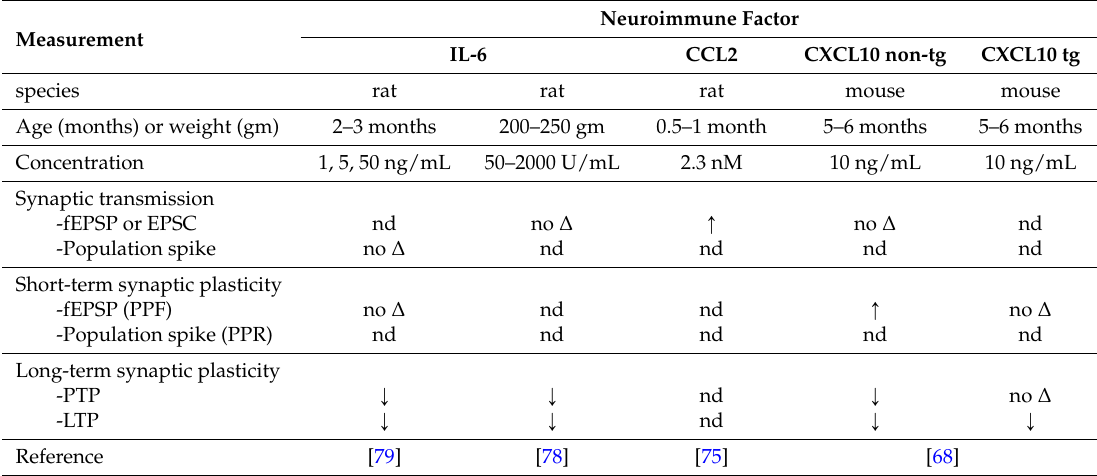
Table 2. Effects of exogenous application of neuroimmune factor on synaptic function in hippocampus.